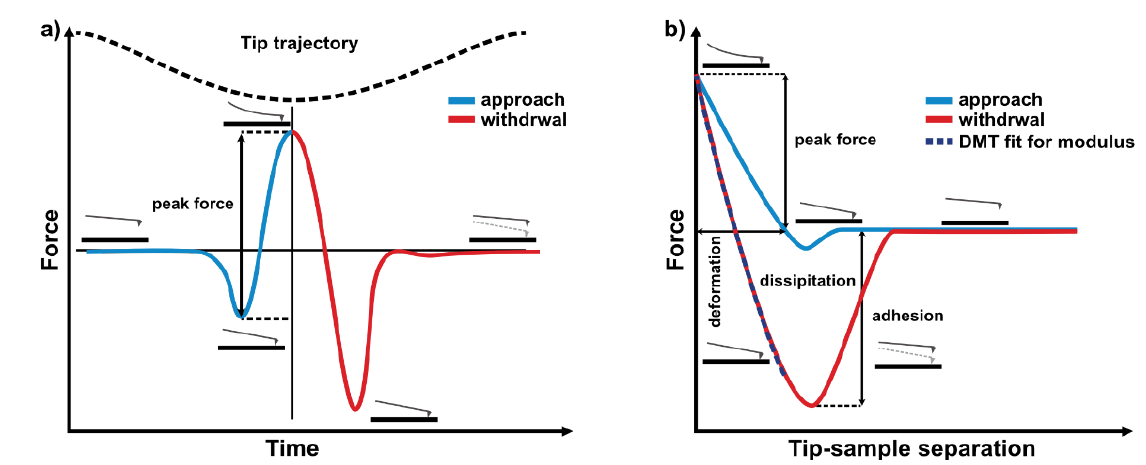
Figure 1. ( a ) Scheme of the force curves for a cantilever operating in Peak Force Tapping, ( b ) scheme of the single cycle force vs. separation curve with the dark blue dashed line fitted to the retract curve using the Derjaguin–Muller–Toporov (DMT) model.